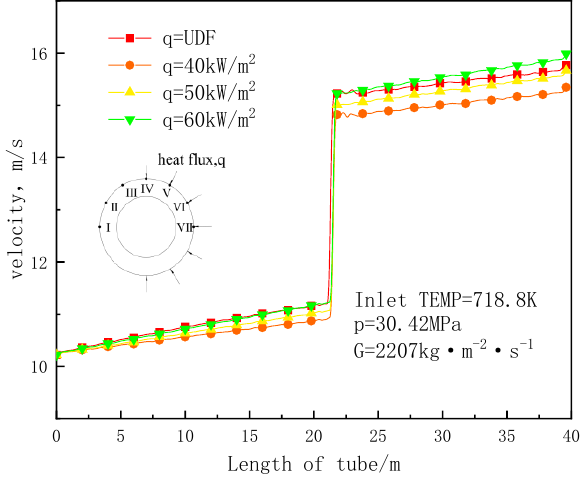
Figure 9. Velocity distribution of the tube length at different heat fluxes ( p = 30.42 MPa, G = 2207 kg/ ( m 2 ·s ) , q = 39.8~71.2 kw/m 2 ).